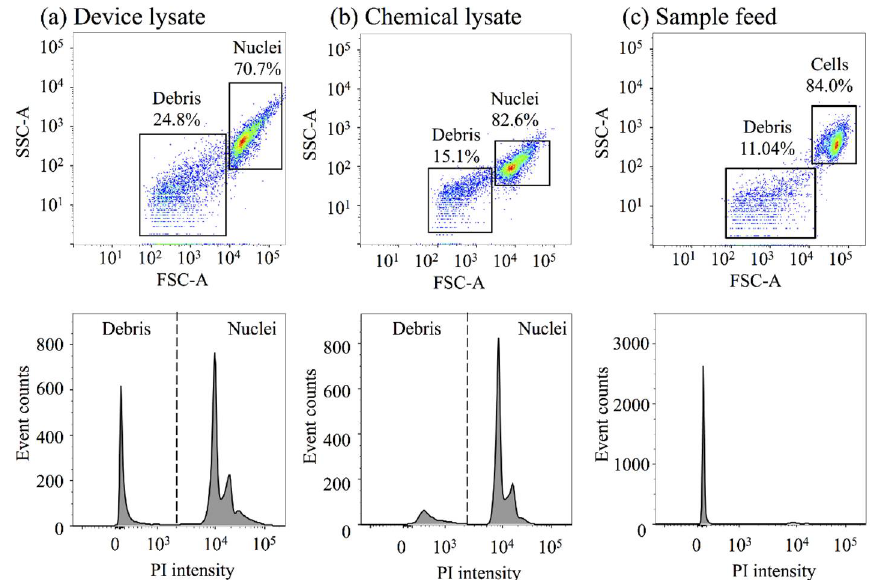
Figure 5. Representative scatter plots of forward-scattered (FSC) and side-scattered (SSC) data and the corresponding histograms of propidium iodide (PI) intensity from ( a ) a device lysate (from a four-constriction treatment) and ( b ) a chemical lysate, as well as ( c ) the sample feed (untreated cells). The constrictions are w = 10 µ m and d = 7 µ m.